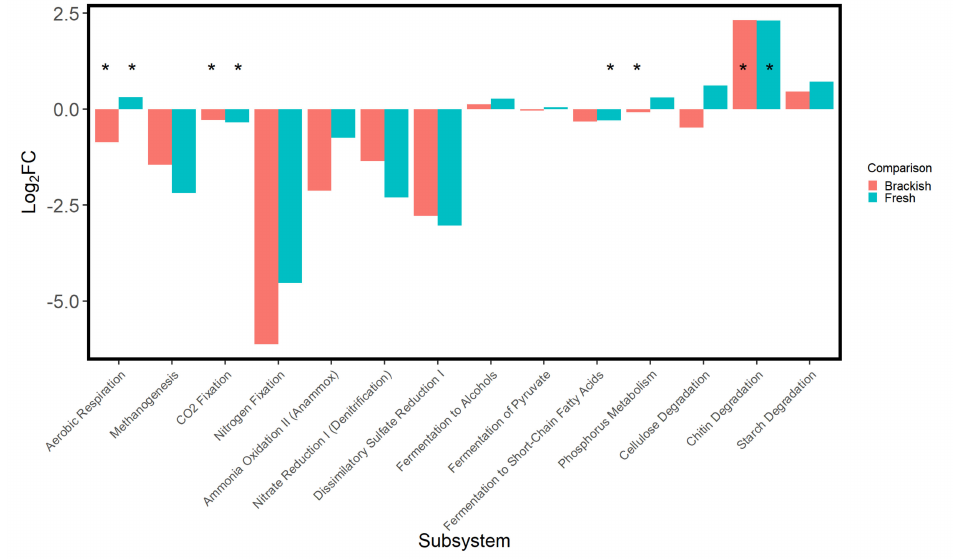
Figure 6. Di ff erential abundance of MetaCyc subsystems in microbial communities in brackish and tidal fresh wetlands as compared to a saltpan wetland in the same area of Grand Bay National Estuarine Research Reserve in southeast Mississippi, USA. Log 2 FC was used as a measure, of which functional groups had more or fewer pathways expressed when comparing each tidal wetland to the saltpan based on di ff erences in the taxa present. Fold change represents the di ff erence between the saltpan amplicon counts and the amplicons counts of the brackish (red) and fresh (blue) tidal wetlands. Those functional groups which were represented by more amplicons in either the brackish or fresh wetland show positive change and those which had more amplicons in the saltpan sediment show negative change. MetaCyc enrichment analysis determined which functional groups showed a significant di ff erence (*), based on the raw number of daughter pathways which di ff ered in amplicon